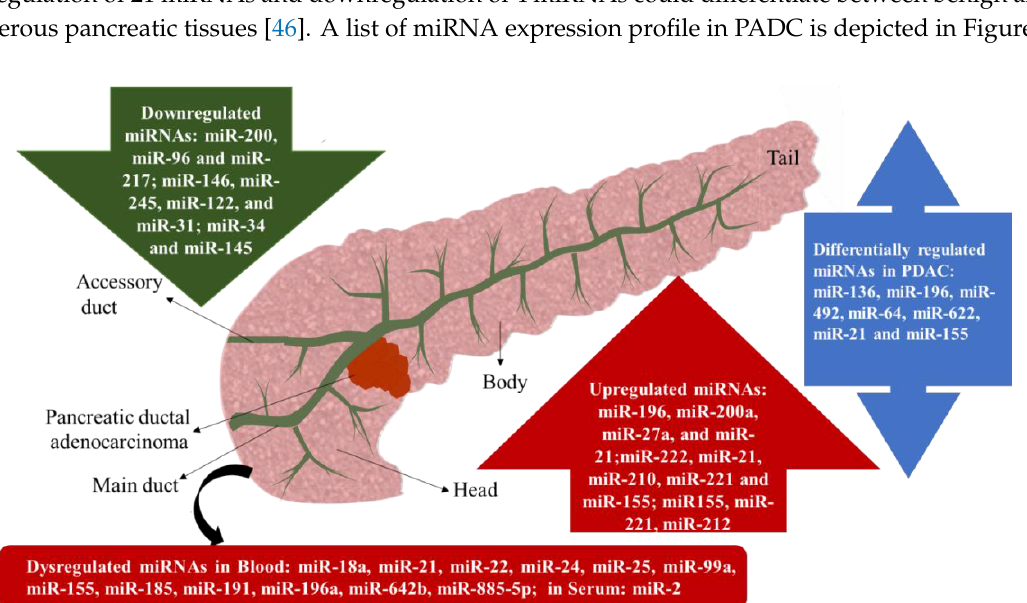
Figure 2. The major structures of the pancreatic gland indicating the origin of PDAC. A cataloug of commonly downregulated miRNAs (in green), upregulated miRNAs (in red) and differentially regulated miRNAs (in blue) in PDAC are listed in different colors. Differentially regulated miRNAs refers to either up or down-regulated miRNAs compared to healthy pancreatic tissue.